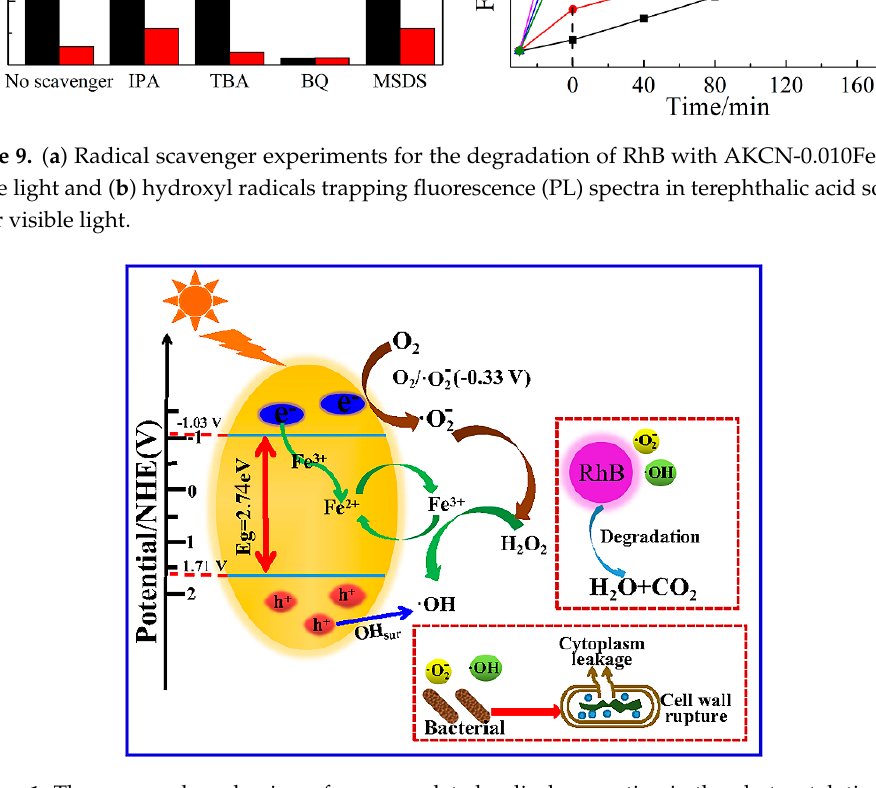
Scheme 1. The proposed mechanism of oxygen-related radical generation in the photocatalytic system coupled with the Fenton reaction (AKCN-0.010Fe) under visible light